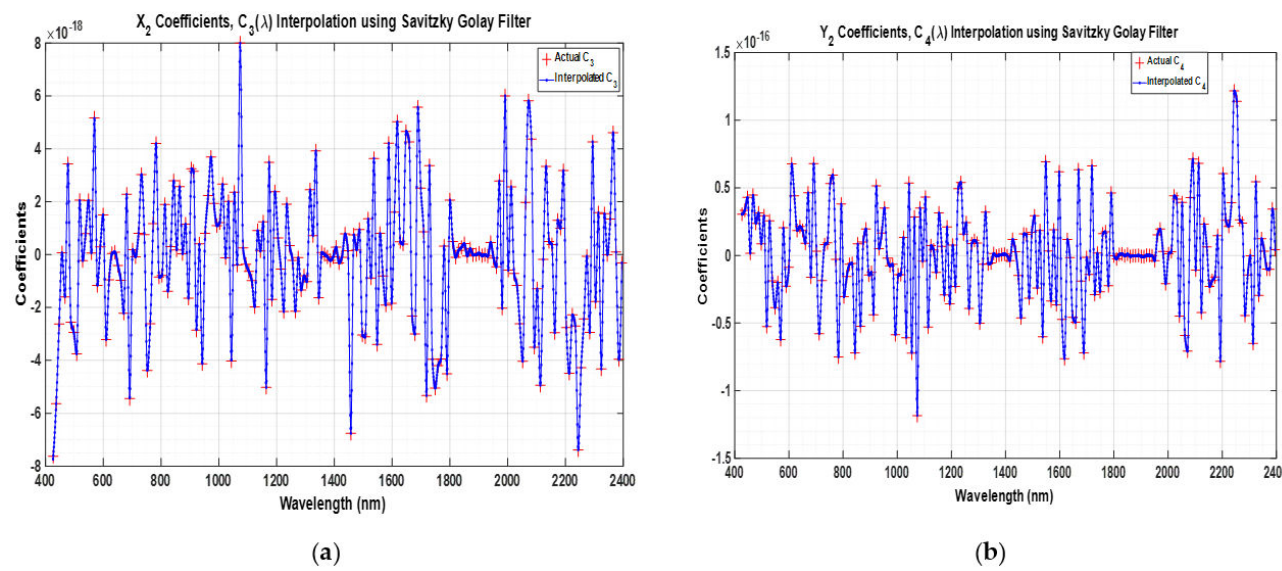
Figure 6. Interpolated ( a ) X 2 coefficients, C 3 ( λ ) and ( b ) Y 2 coefficients, C 4 ( λ )